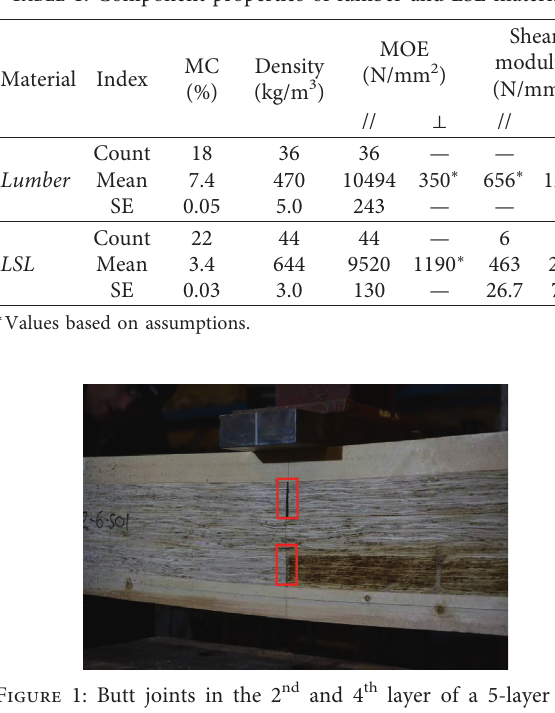
Table 1: Component properties of lumber and LSL materials.